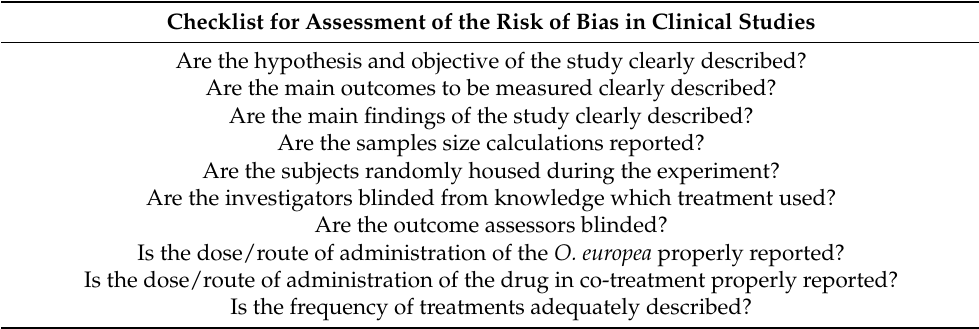
Table 5. Checklist for assessment of risk of bias in pre-clinical studies [17,126]. Checklist for Assessment of the Risk of Bias in Pre-Clinical Studies Are the hypothesis and objective of the study clearly described? Are the main outcomes to be measured clearly described? Are the main findings of the study clearly described? Are the samples size calculations reported? Are the animals randomly housed during the experiment? Are the investigators blinded from knowledge which treatment used? Are the outcome assessors blinded? Is the dose/route of administration of the O. europea properly reported?